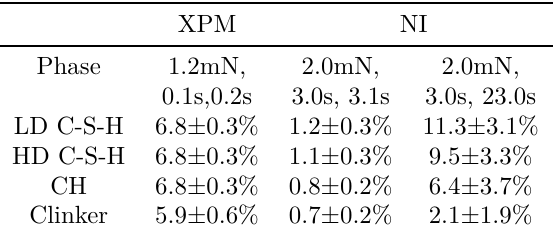
values are higher than the literature results [6, 7].